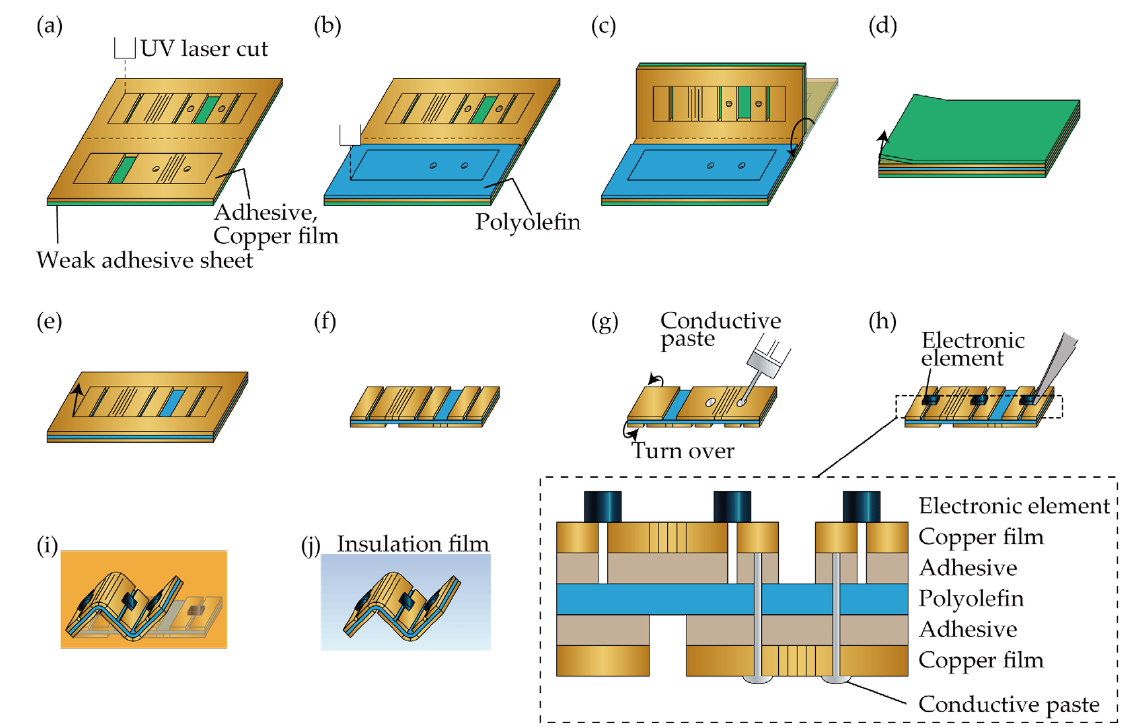
Figure 2. Device fabrication. ( a ) Slitting adhesive and copper film. ( b ) Slitting polyolefin. ( c ) Pasting together. ( d ) Removal of support material. ( e ) Removal of unwanted parts. ( f ) Devices after removal of unwanted parts. ( g ) Filling of the conductive paste. ( h ) Mounting of electronic elements. ( i ) Self-folding. ( j ) Insulating film deposition.